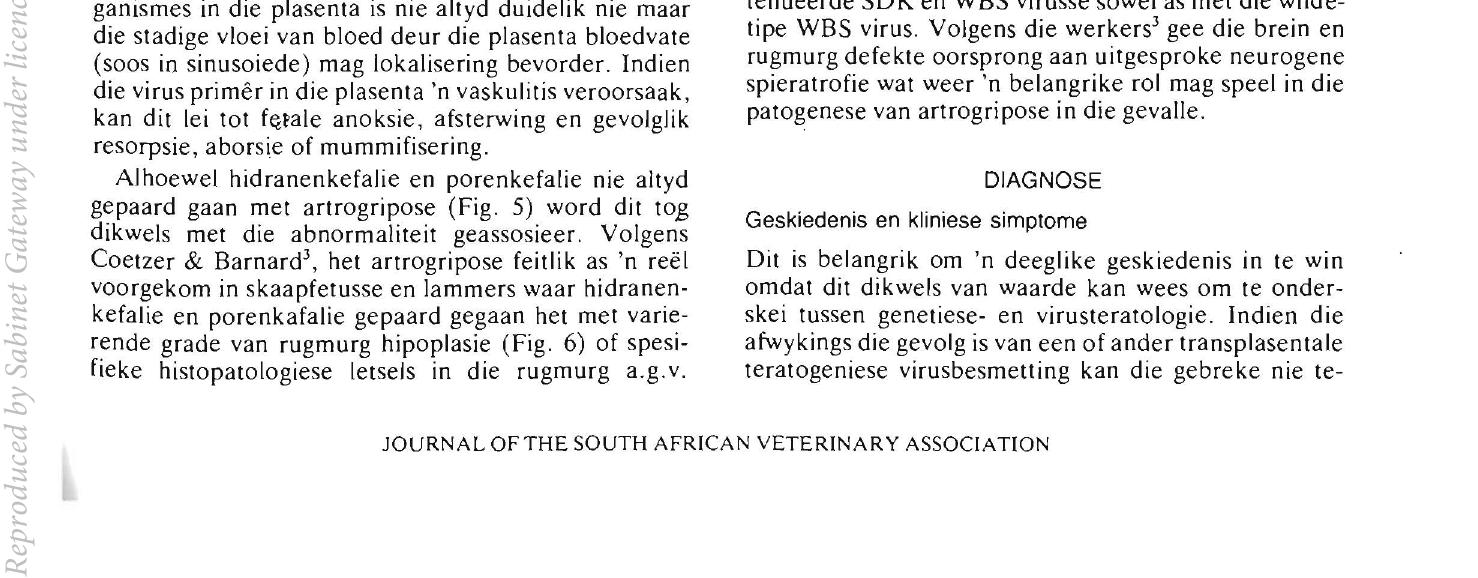
Fig. 6. Let op die opvallende rugmurg hipoplasie.